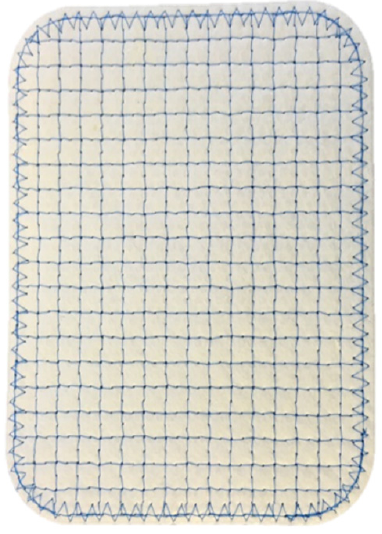
Figure 1. OviTex RTM mesh.